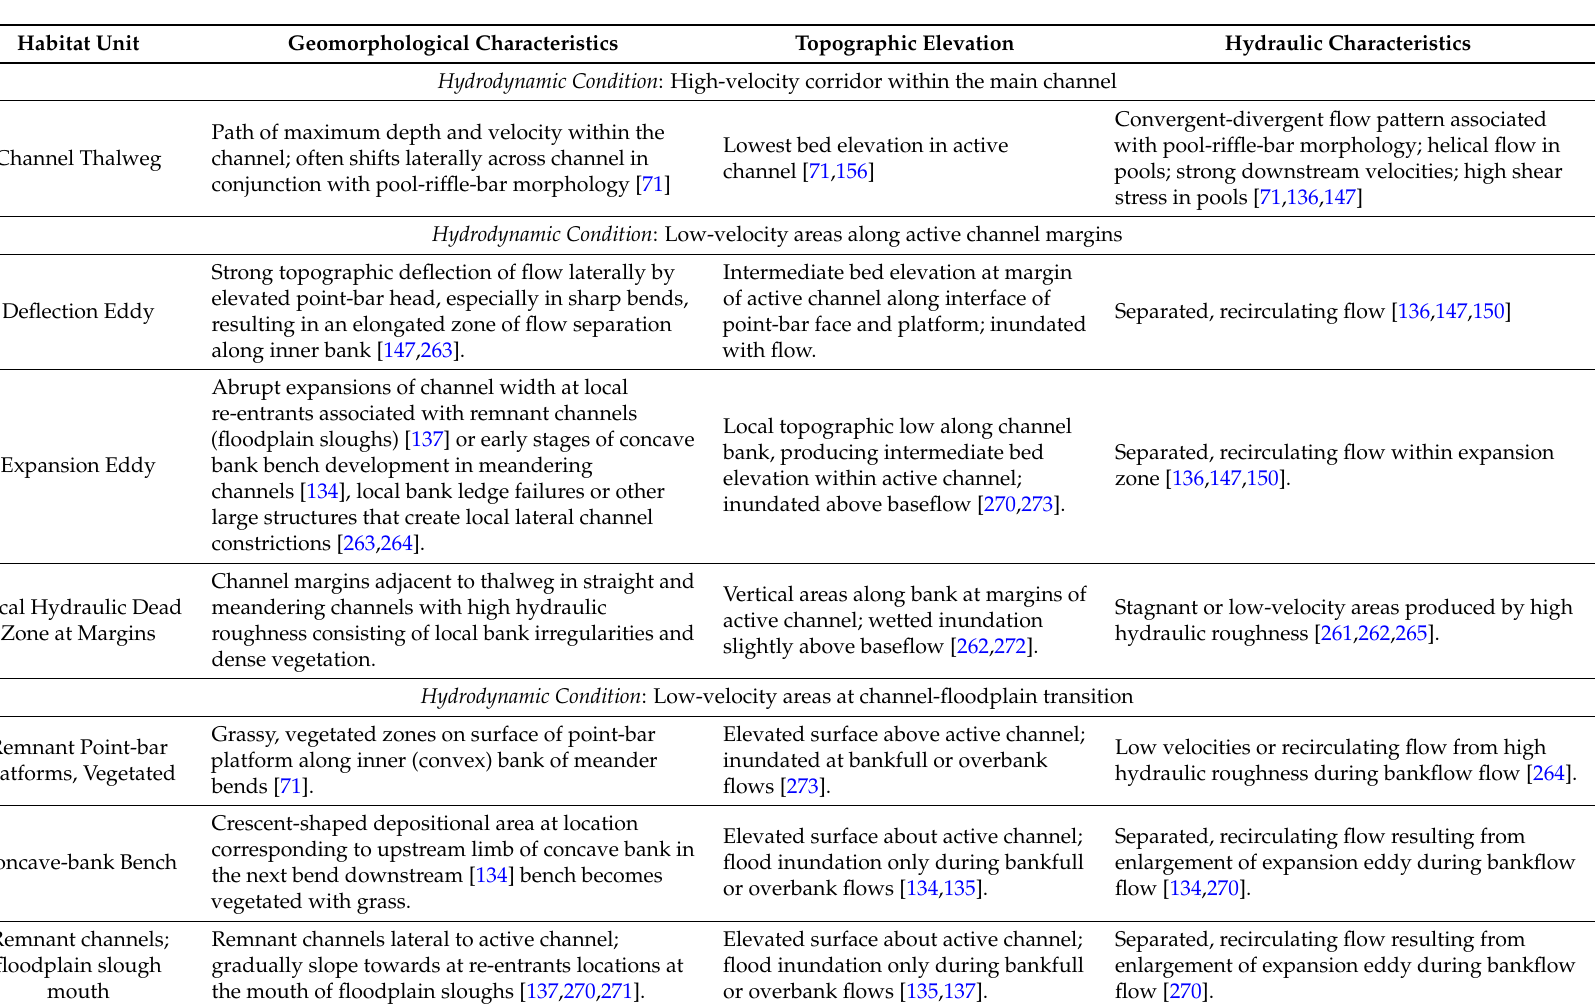
Table 3. Geomorphological and hydraulic characteristics of fluvial habitat units during high-flow stages in small, low-gradient streams in the Midwest, USA. Table modified from